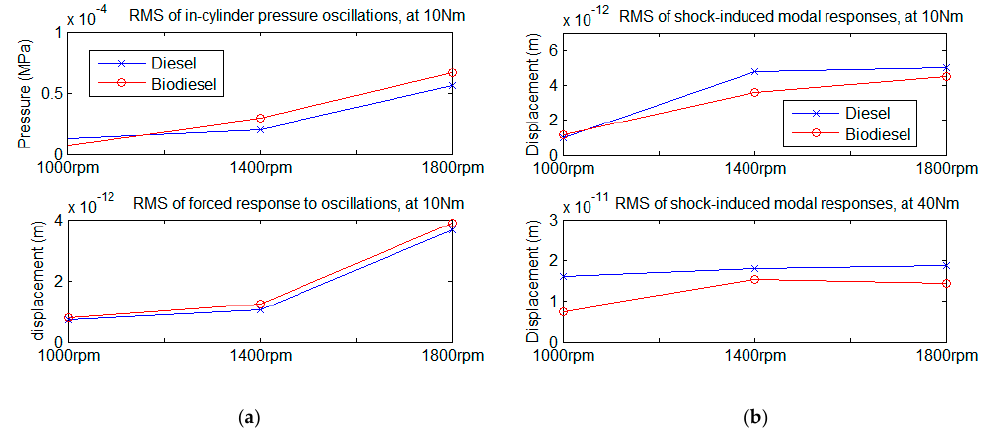
Figure 15. The variation trends of combustion shock-induced events; ( a ) Root mean square (RMS) results of pressure oscillations and Impact Co event; ( b ) Root mean square (RMS) results of Impact Cs under different loads.